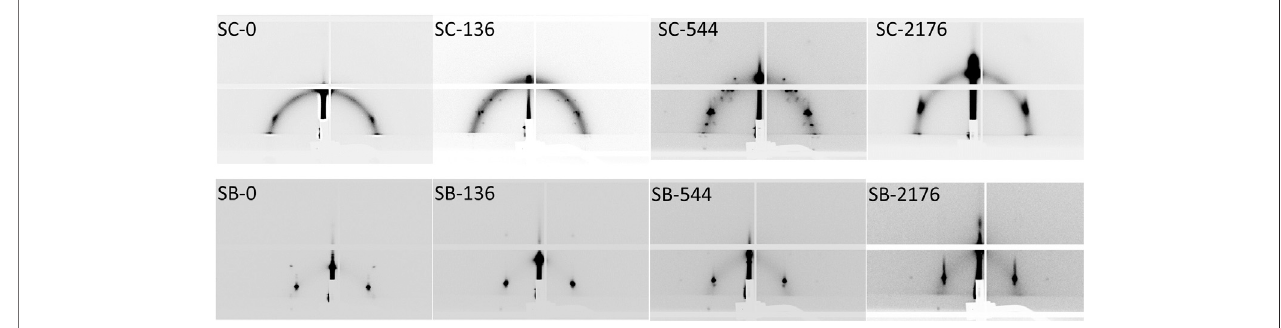
FIGURE3| GI-SAXSpatternsobtainedfortheas-prepared fi lm(SC-0andSB-0)andforselectedirradiated fi lmsinSC (upperrow) andSB (lowerrow) systems.